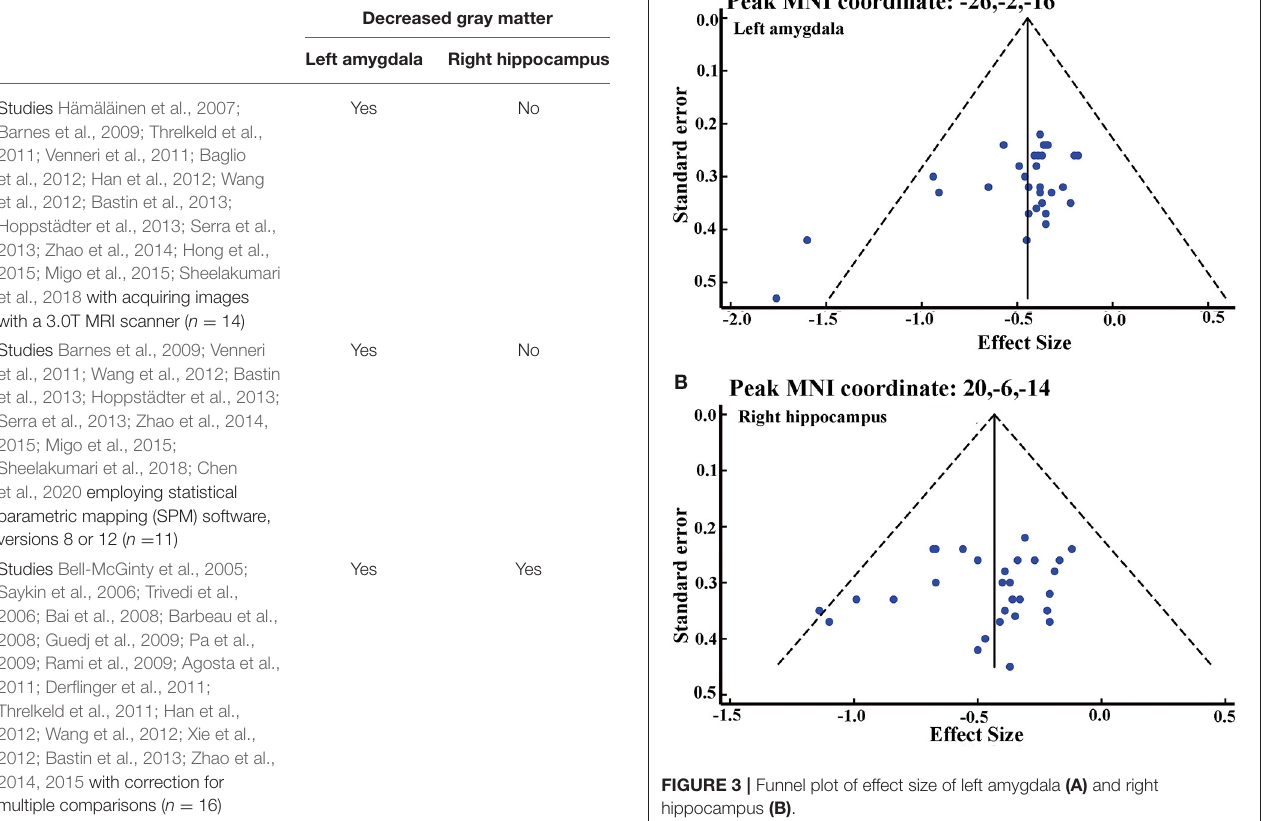
TABLE 3 | Results of analyses of subgroups.